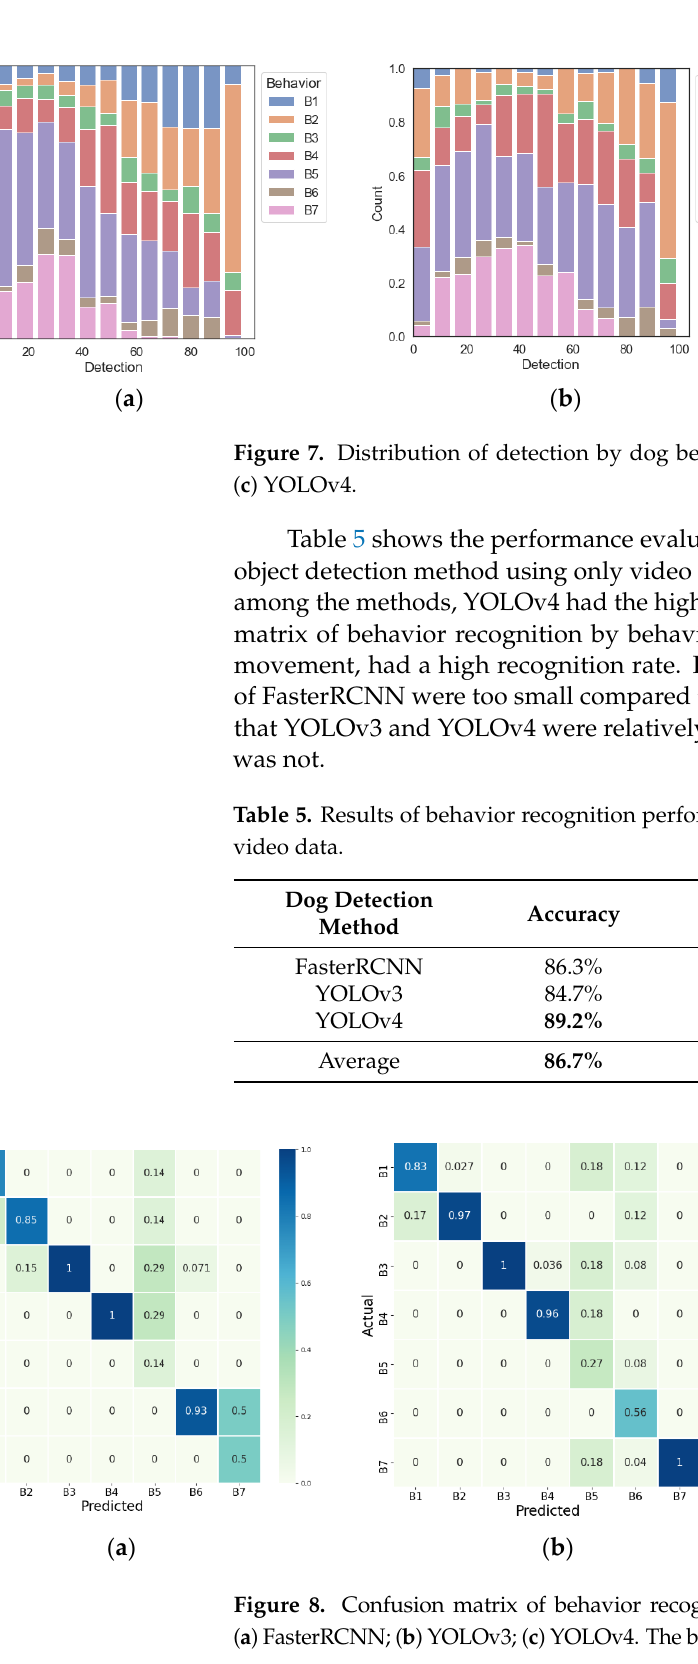
Figure 6. Distribution of detection by method according to the amount of data.